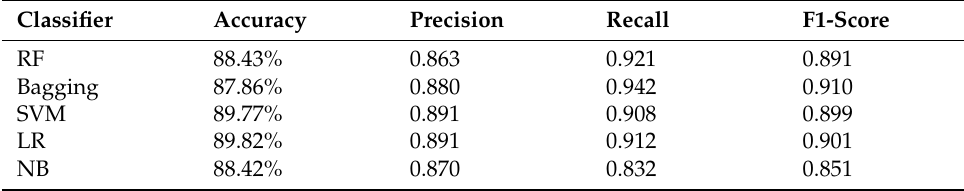
Table 16. Experiments with ML models and Word2Vec on Arab TextBlob sentiments.